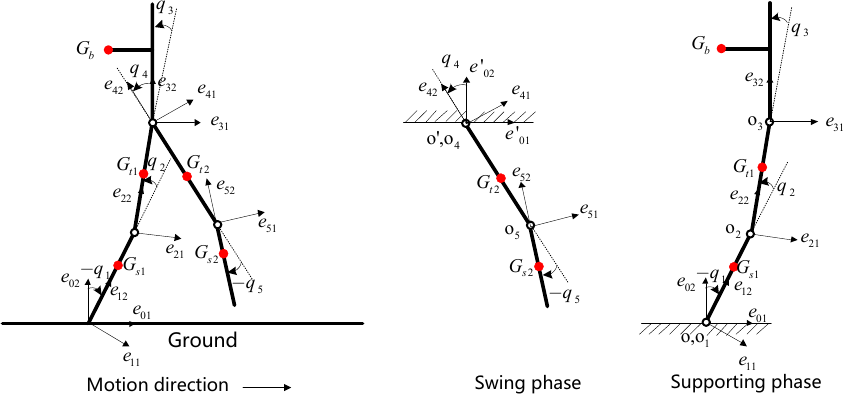
Figure 15. Simplified structure in sagittal plane.